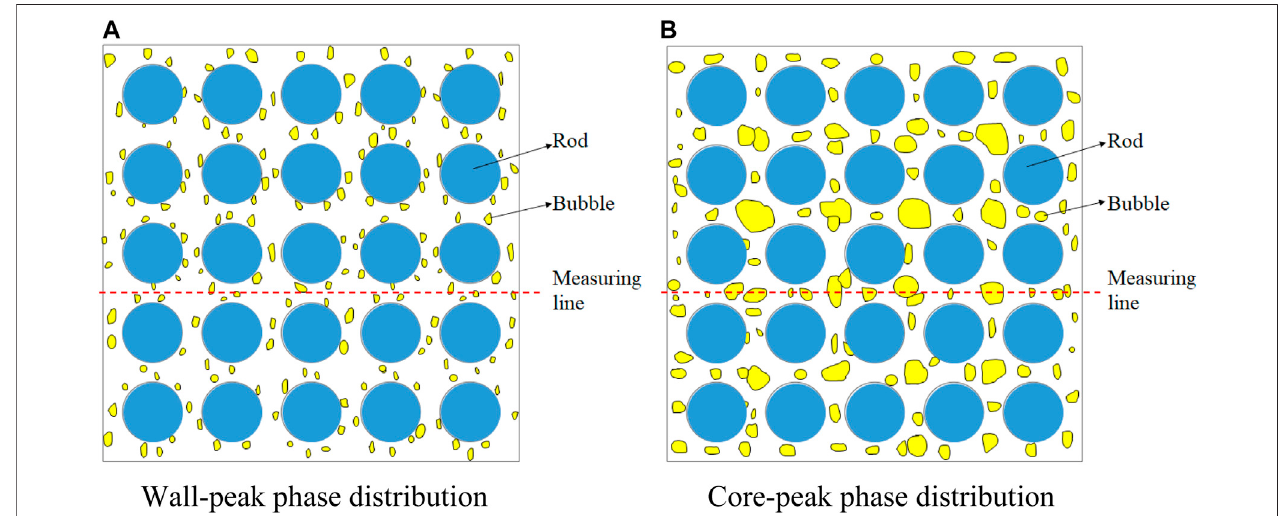
FIGURE 1 | Schematic of the typical phase distribution in rod bundles (top view). (A) Wall-peak phase distribution. (B) Core-peak phase distribution.